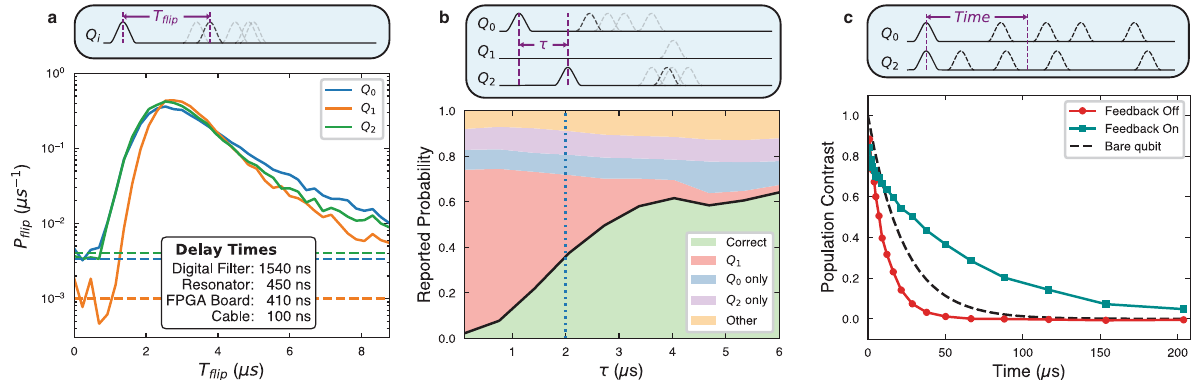
Fig. 3 Characterizing the time to correct an error. a Histogram of time between an induced error and the correction pulse for each of the qubits, normalized such the integral of the probability density P flip ( t ) gives the detection probability. Dashed lines indicate the dark count rates for each error type. b Probability of detecting certain fl ip sequences given a fl ip on Q 0 at time zero preceding a fl ip on Q 2 at time τ . The green region is the probability of the controller correctly detecting a Q 0 fl ip and then a Q 2 fl ip. The red region is the probability of the controller detecting a Q 1 fl ip, resulting in a logical error. The dotted line indicates the dead time, when these two probabilities are equal. c Population decay of the excited logical state, 101 j i , of the odd-odd subspace with and without feedback. With feedback on, the lifetime of the logical basis state is longer than that of an individual bare